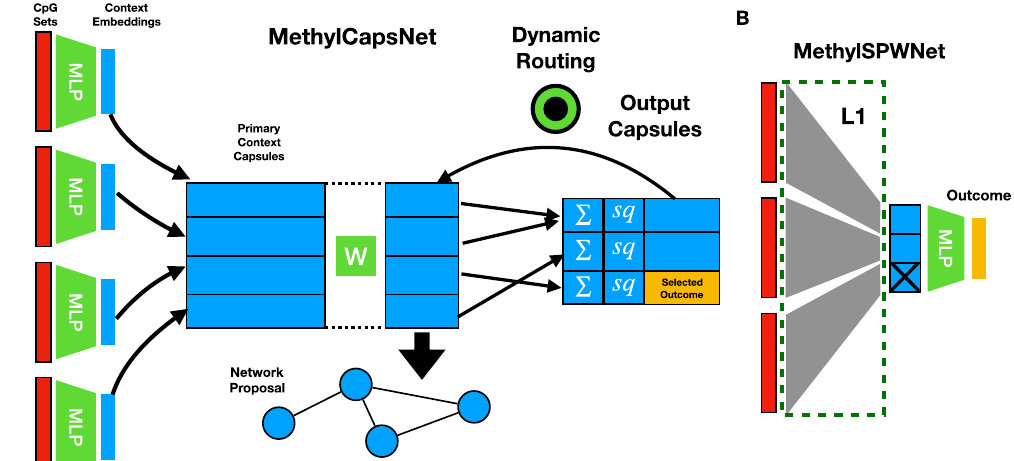
Fig. 1 Description of modeling approaches. A MethylCapsNet: separate MLPs are utilized to form capsule level embeddings from beta values of CpG groupings, which are then associated with outcome targets of interest through dynamic routing of information; these embeddings may be studied to propose networks based on comethylation on the individual level. B MethylSPWNet aggregates the beta values of groups of CpGs through one locally connected layer; nodes of the resulting layer represent biologically meaningful units that are passed through an MLP for fi nal prediction; group L1 penalties are applied to prune genes/capsules potentially unrelated to the outcome; red colors indicate beta values for CpGs, which serve as input to the